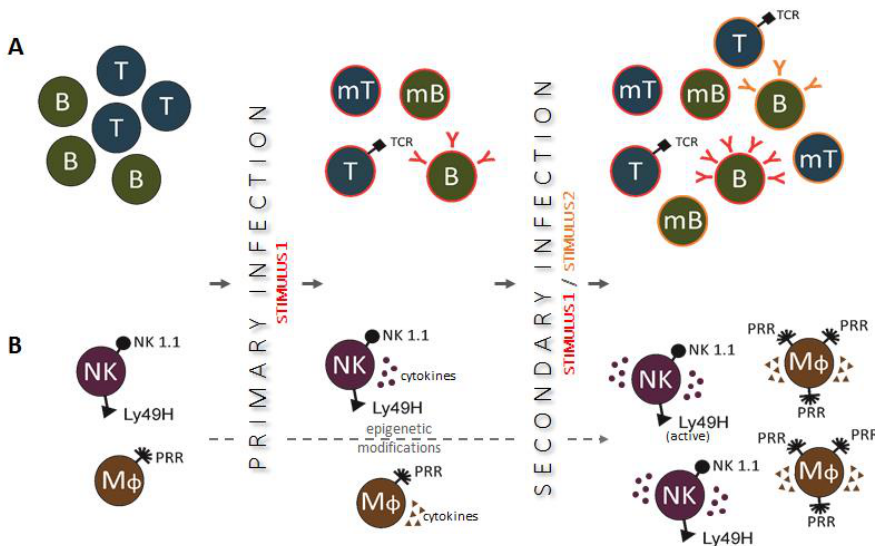
Figure 1. Primary and secondary immune responses in adaptive (panel A ) and innate (panel B